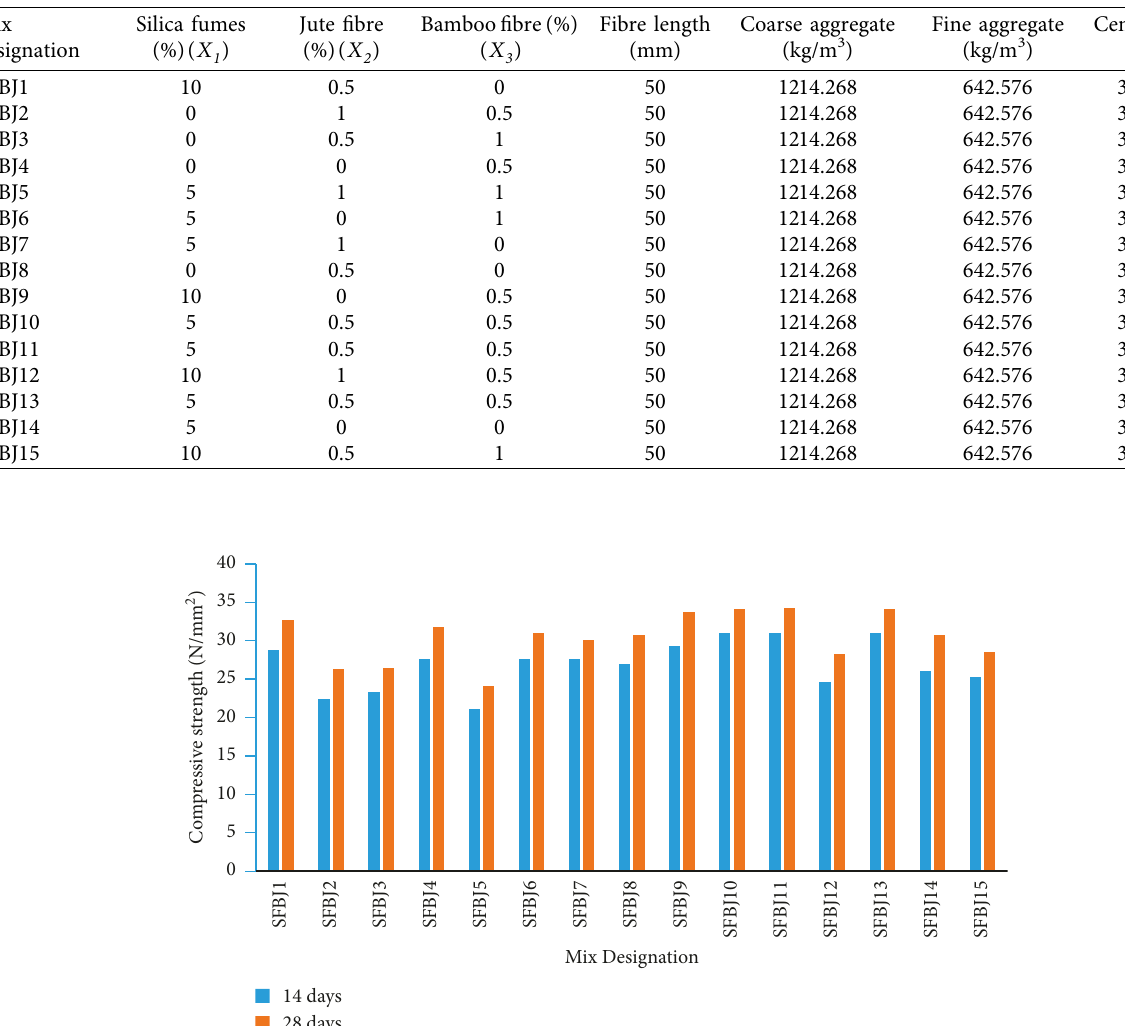
Figure 1: (a) Bamboo fibre and (b) jute Table 3: Mix proportion.